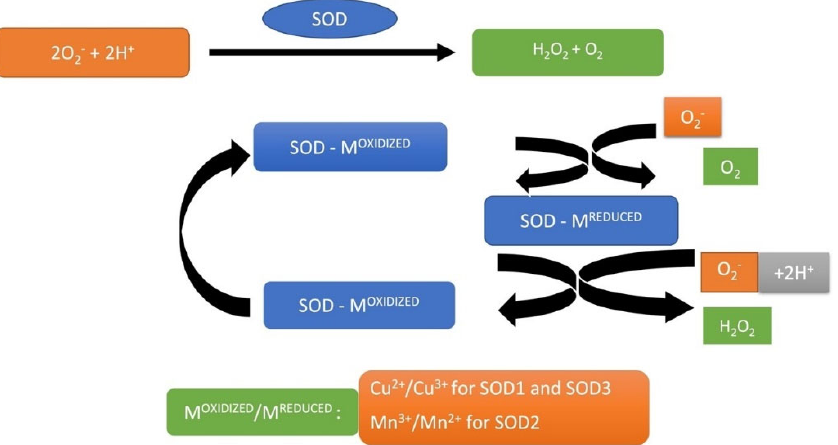
Figure 4. O ‐ 2 • scavenging by SOD with consecutive reduction and re ‐ oxidation of the catalytic metal Figure 4. O 2 •− scavenging by SOD with consecutive reduction and re-oxidation of the catalytic metal (Cu or Mn) in the active region of the enzyme. (Cu or Mn) in the active region of the